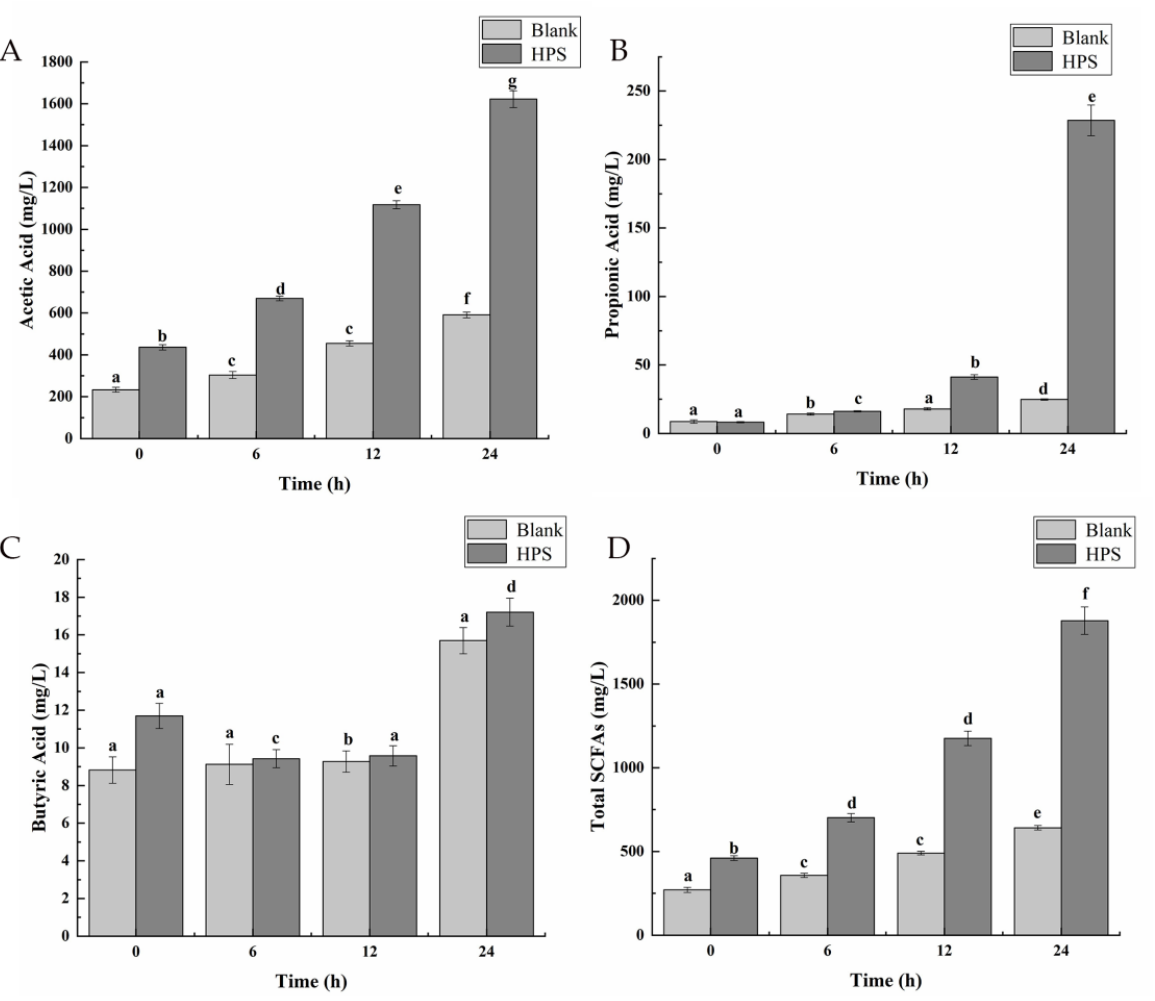
Figure 4. Changes in content of SCFAs during the fecal fermentation of HPS, acetic acid ( A ), propionic acid ( B ), butyric acid ( C ), and total SCFAs ( D ) (the sum of acetic acid, propionic acid, and butyric acid). The values are expressed as the mean ± SEM ( n = 3). Different letters indicated statistical differences ( p <